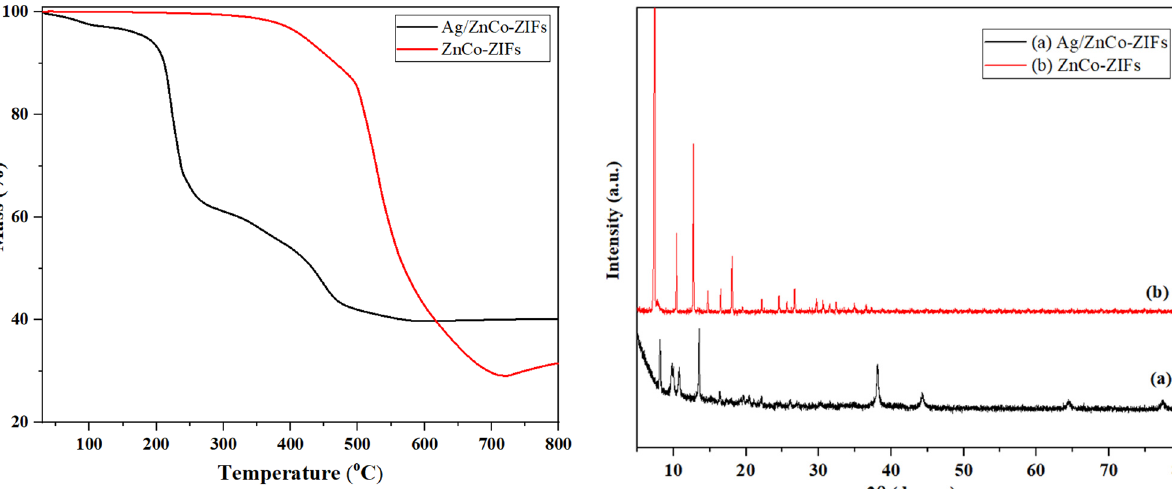
Figure A1: Powder XRD of ( a ) Ag/ZnCo - ZIFs and ( b ) ZnCo - ZIFs.